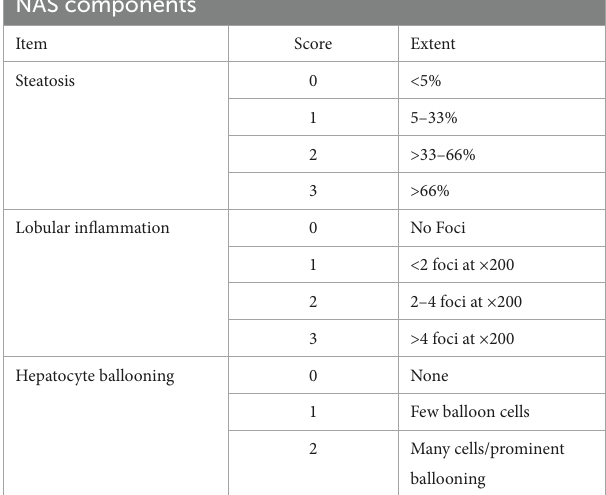
TABLE 1 Nonalcoholic fatty liver disease activity scores (NAS). NAS